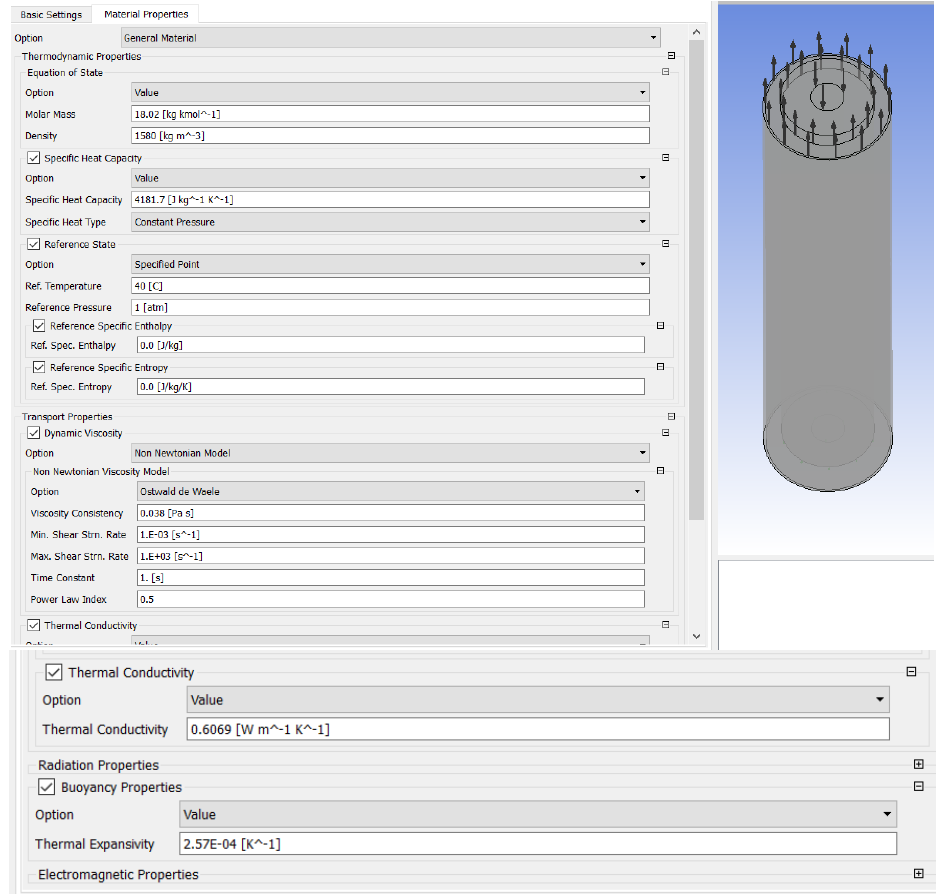
Figure A3. Properties and parameters of the drilling mud in the well .